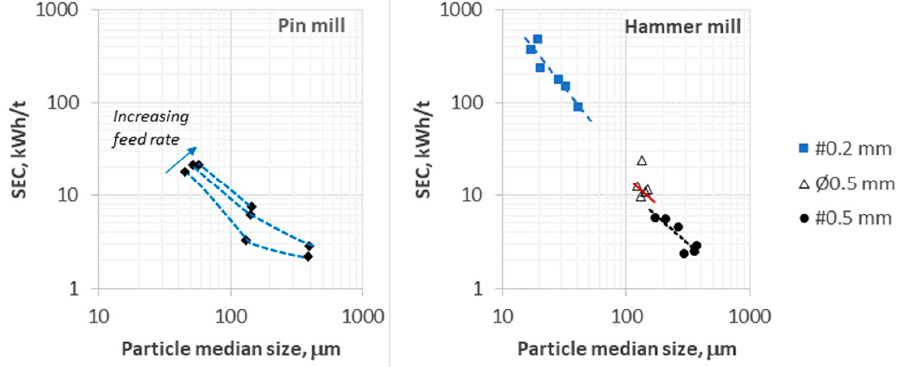
Figure 7. SEC as a function of particle size; pin mill in left, hammer mill in right. The dashed lines in pin milling emphasize the effect of the production rate.